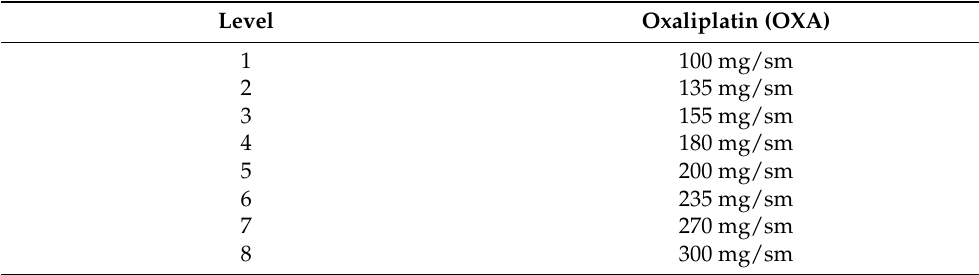
Table 2. Oxaliplatin dose escalation